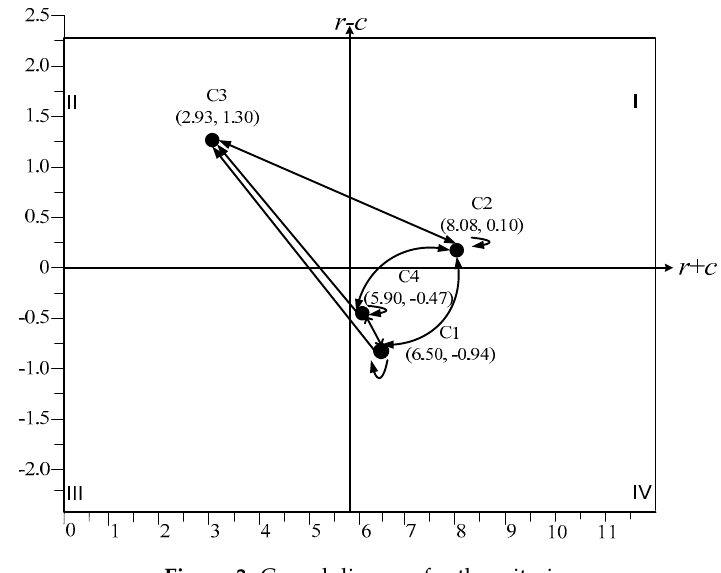
Figure 3. Causal diagram for the criteria.